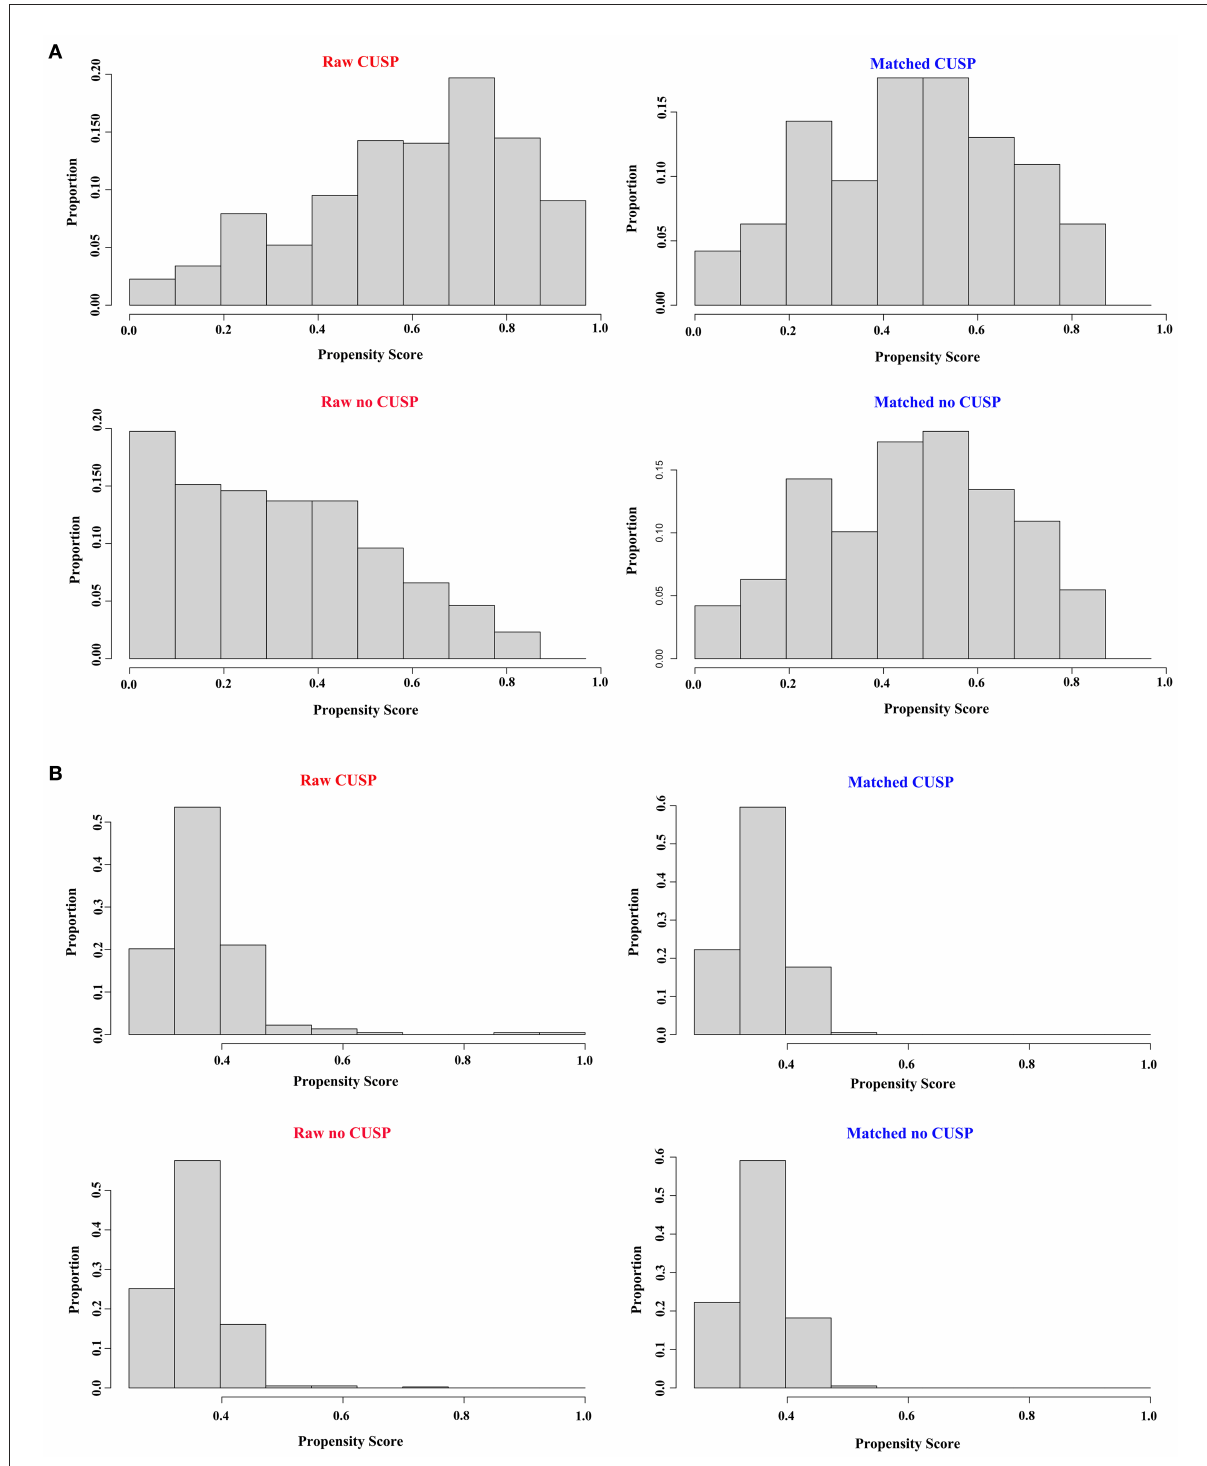
FIGURE3 Distribution of propensity scores in the TICU and SCIU setting between the no CUSP and CUSP groups. (A) Before matching [left panel (A) ] and after matching [right panel (A) ] in the TICU setting. (B) Before matching [left panel (B) ] and after matching [right panel (B) ] in the SICU setting. TICU, transplantation intensive care unit; SICU, surgical intensive care